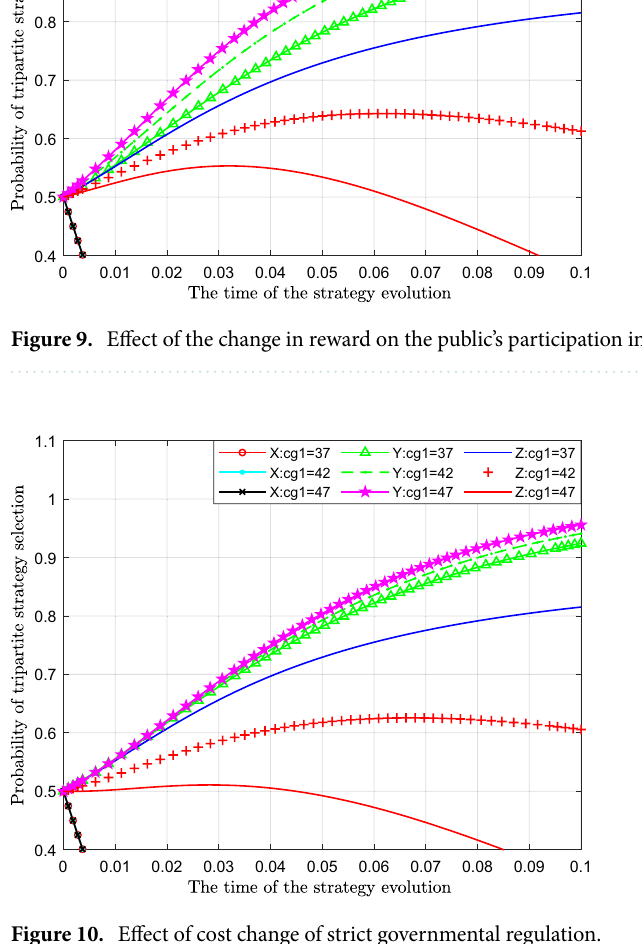
Figure 10. Effect of cost change of strict governmental